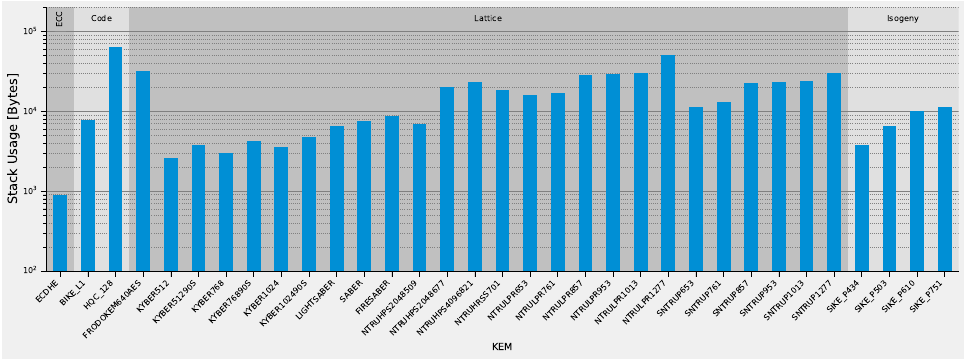
Figure 9. Stack usage of the encapsulation operation of the NIST Round 3